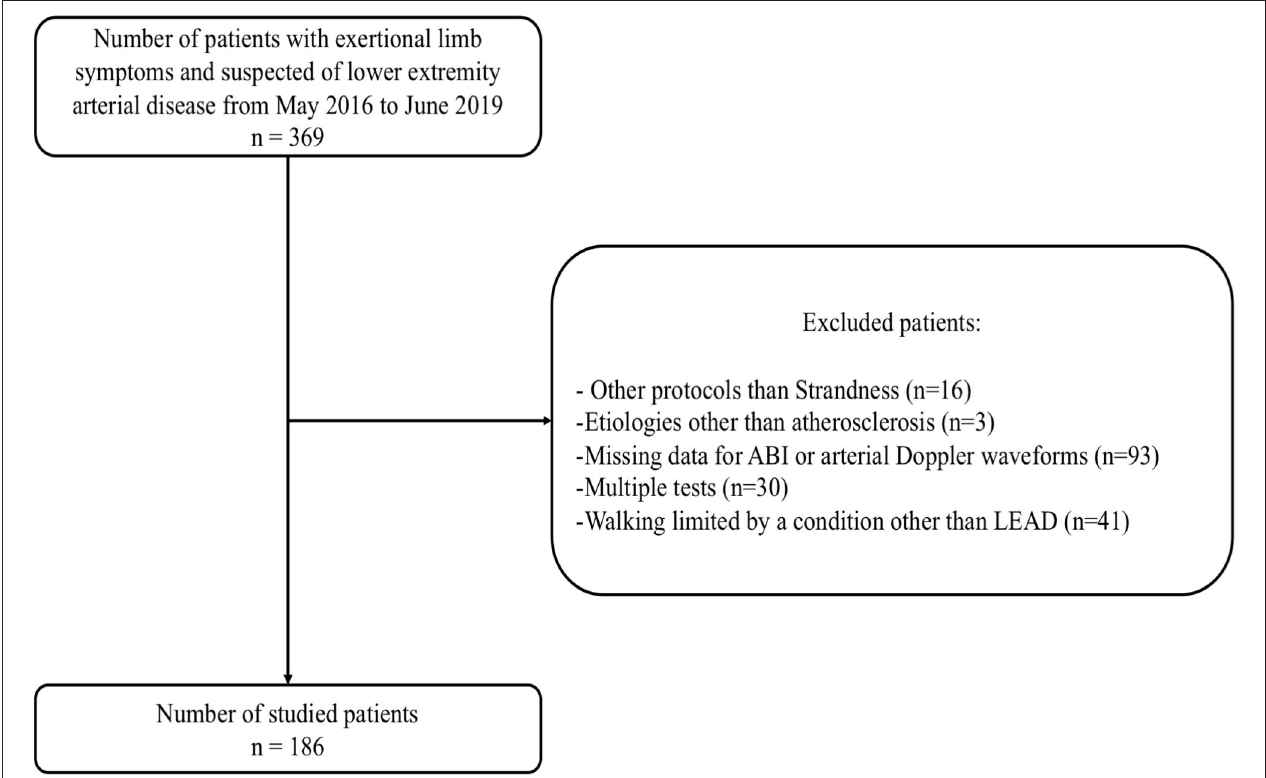
FIGURE 2 | Flowchart of included